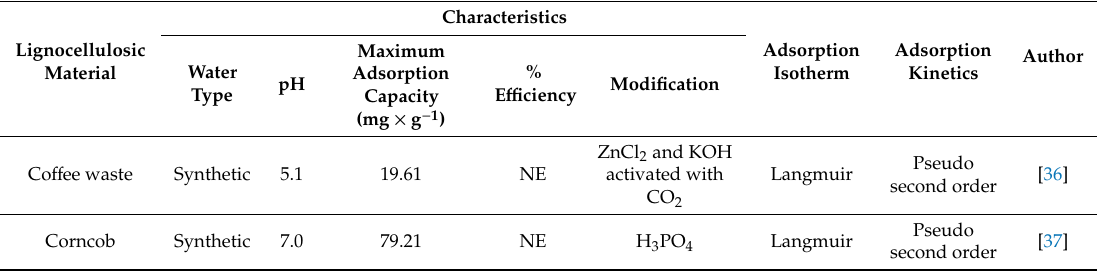
Table 5. Maximum adsorption capacity of co ff ee wastes with chemical modification used for the biosorption of Zn(II).